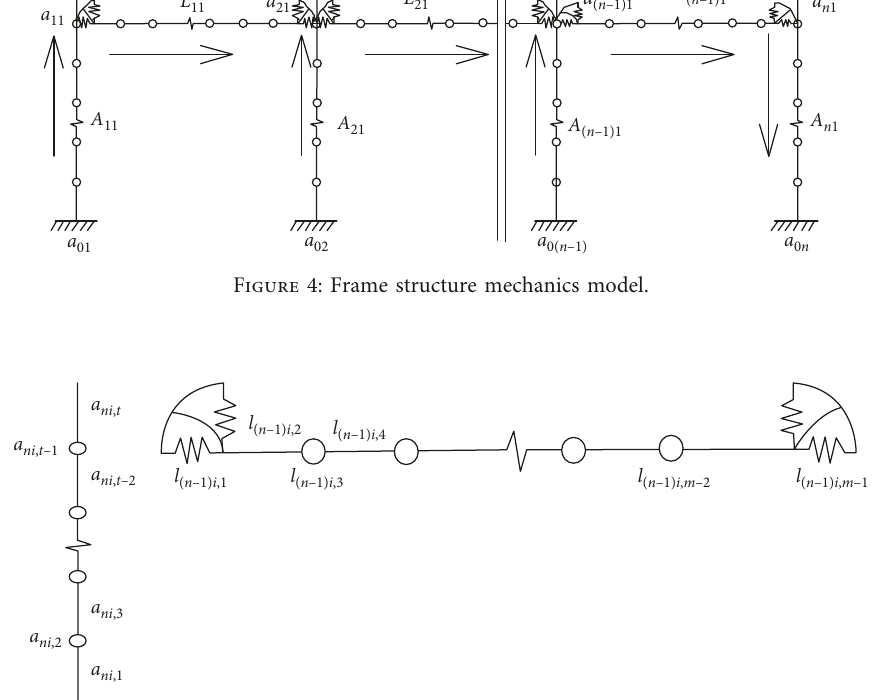
Figure 5: Mechanical model of beam and column. Calculation diagram of (a) frame column A